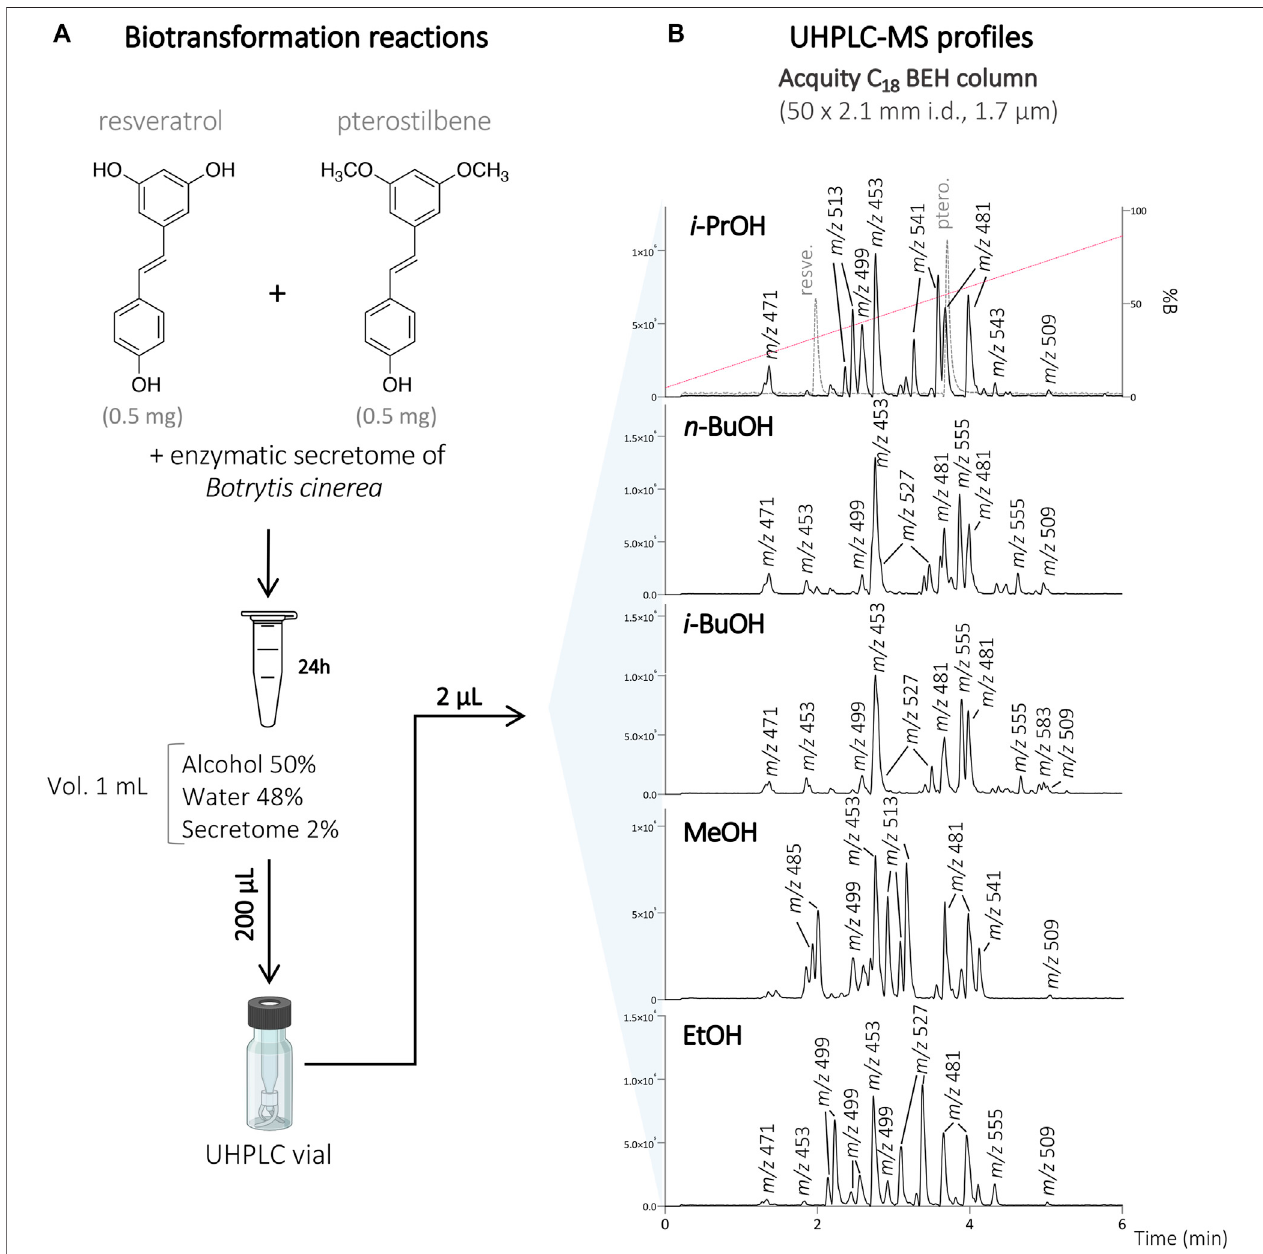
FIGURE1|(A) Biotransformationreactionsofthemixtureofresveratrolandpterostilbenewiththesecretomeof Botrytiscinerea inthepresenceof50%ofdifferent organic solvents( i -PrOH, n -BuOH, i -BuOH,MeOH,EtOH). (B) UHPLC-MS pro fi leofthedifferent reactions at theanalyticalscale using anAcquity C 18 BEH column 50× 2.1 mm i.d., 1.7 µm. The retention times of the starting compounds resveratrol and pterostilbene are indicated by the dashed line on the reaction with i -PrOH. The molecular ion species for all the main compounds detected are indicated with their corresponding m/z